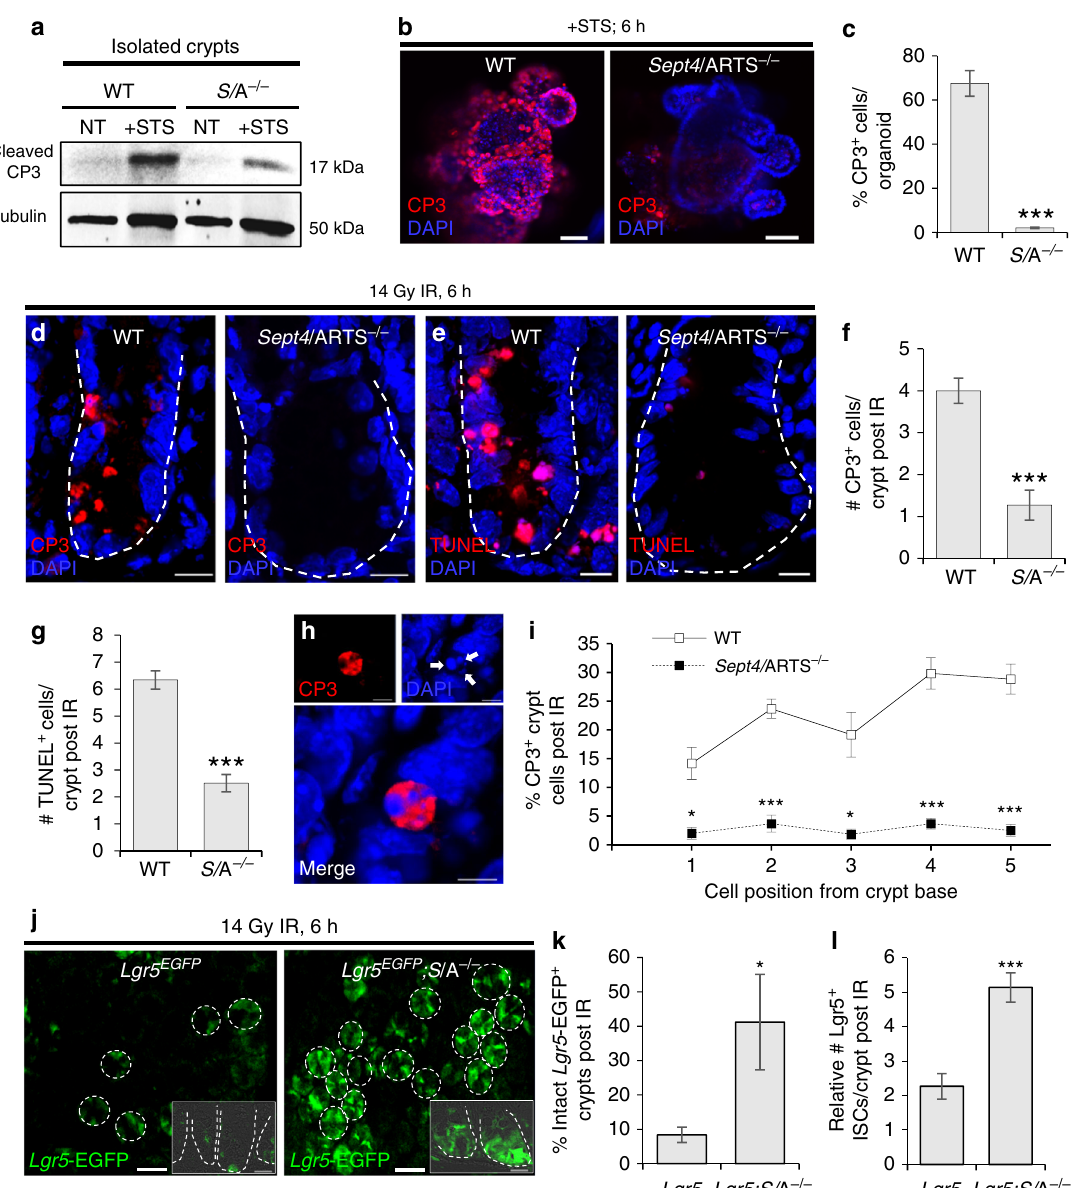
Fig. 3 Deletion of Sept4 /ARTS protects intestinal crypt cells against apoptotic cell death. a Western blot of freshly isolated crypts extracted from wild-type (WT) and Sept4 /ARTS − / − ( S/ A − / − ) mice [ n = 3 pooled intestines per genotype], stained for cleaved caspase-3 (CP3) immediately after isolation and after treatment with staurosporine (STS). Tubulin levels were used as a loading control. b WT and S /A − / − organoids treated with STS and stained for cleaved CP3. c Quanti fi cation of percentage of cleaved CP3 + cells per treated organoid [ n = 3 wells per treatment of 3 pooled mice per genotype]. d Intestinal crypts from WT and S /A − / − mice harvested 6 h post 14 Gy abdominal ionizing irradiation (IR), stained for d cleaved CP3 and e